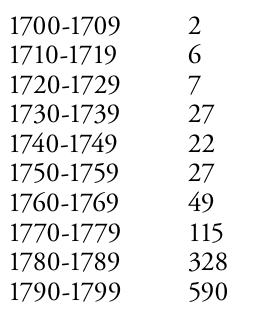
‘Table 1 - Number of works containing